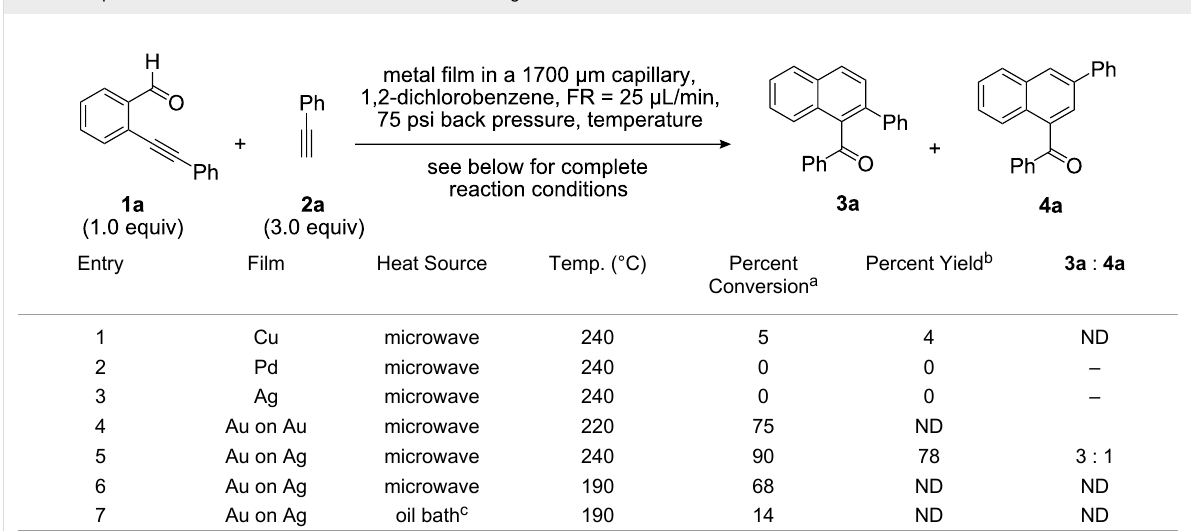
Table 1: Optimization Studies for Benzannulation Reaction using MACOS.